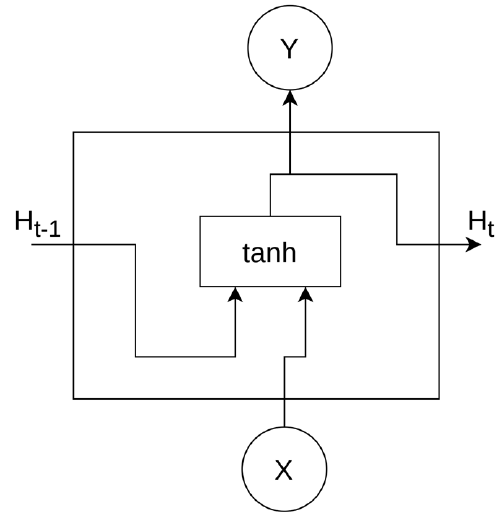
Figure 7. Schematic of an RNN cell.